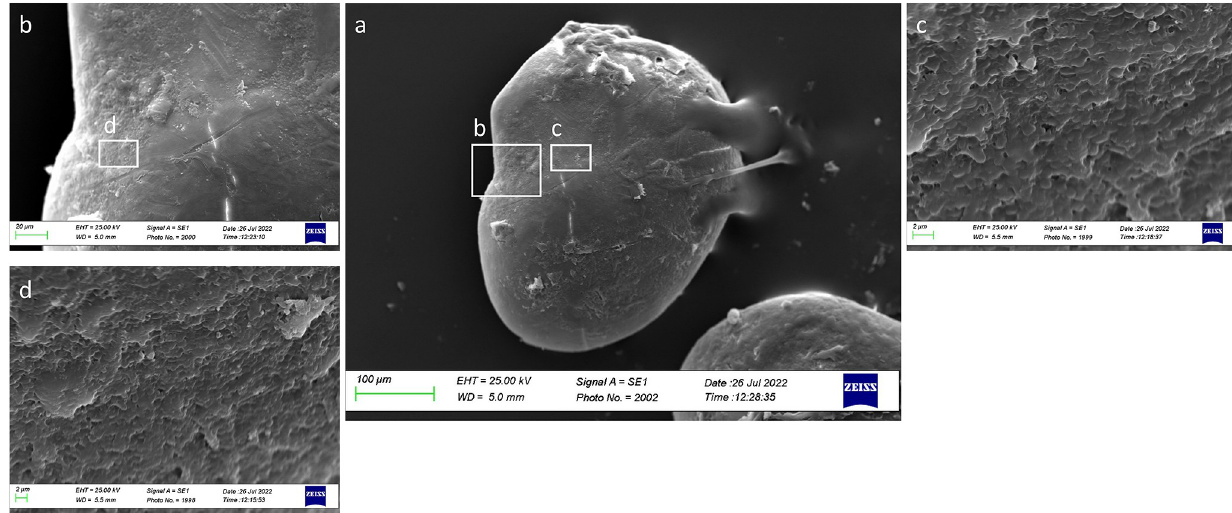
Fig 12. SEM images of a left sagitta inner surface belonging to size Class I (a) with detail of sulcus acusticus (b), ostium (c) and crista superior (d) external textural organization.